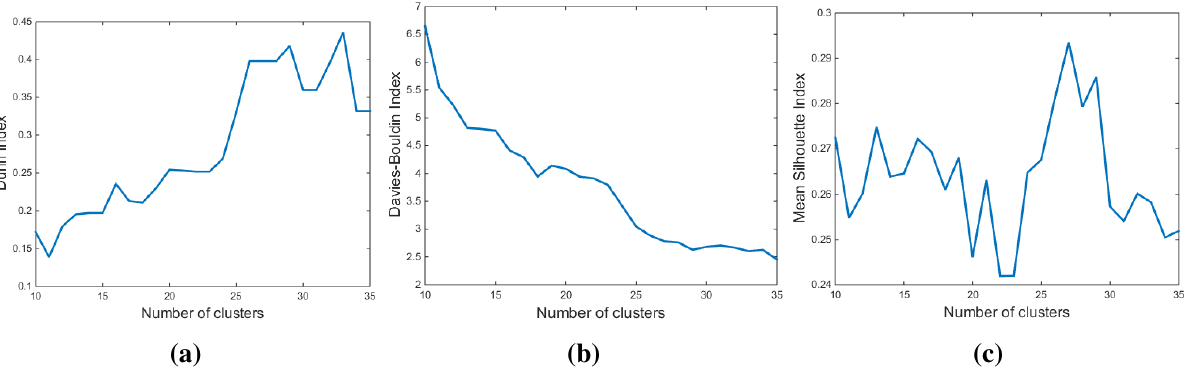
Figure 6. Validating the quality of the clusters produced by K -means algorithm in site B.